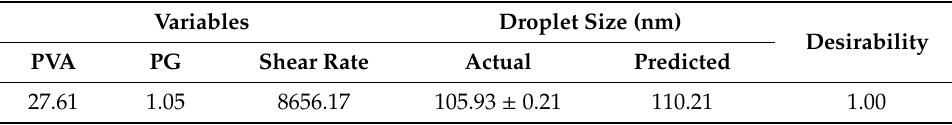
Table 7. Optimum formulation of the KMO nanoemulsion